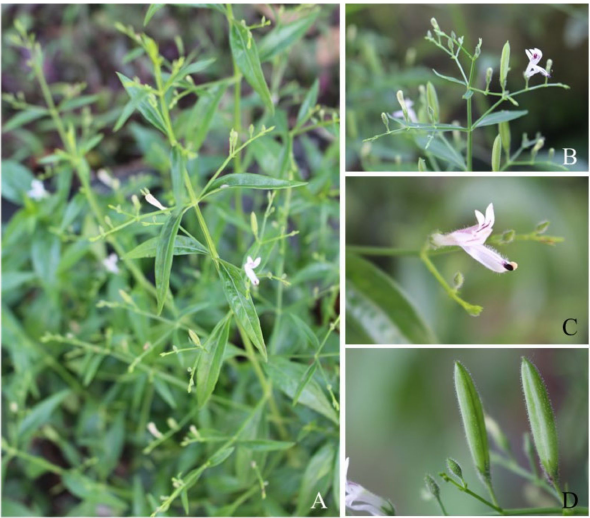
Figure 1. Morphological characteristics of Andrographis paniculata. ( A ): Aerial part, ( B ): fruits and flowers, ( C ): close-up of the flower, and ( D ):